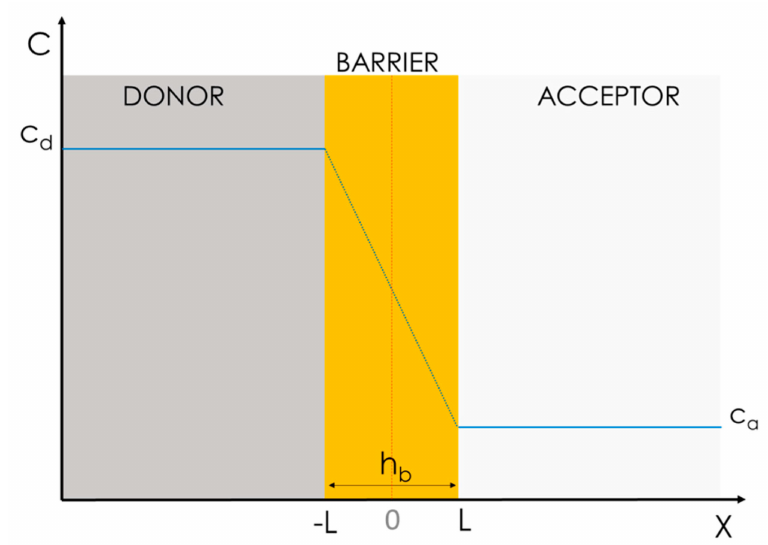
Figure 6. Representation of a conventional physical model used to interpret the passive transport of a compound through a barrier of thickness h b . The blue lines represent the changes in the concentration gradient within the donor (c d ) and acceptor (c a ). In this model, there are no boundary regions, i.e., interfaces, within the water phases of the donor and acceptor media and the barrier (X = − L and X = L,